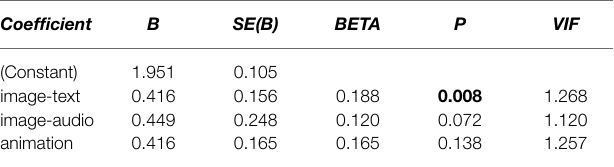
TABLE 10 | Multiple regression between ECL and representation preference ( n = 250).